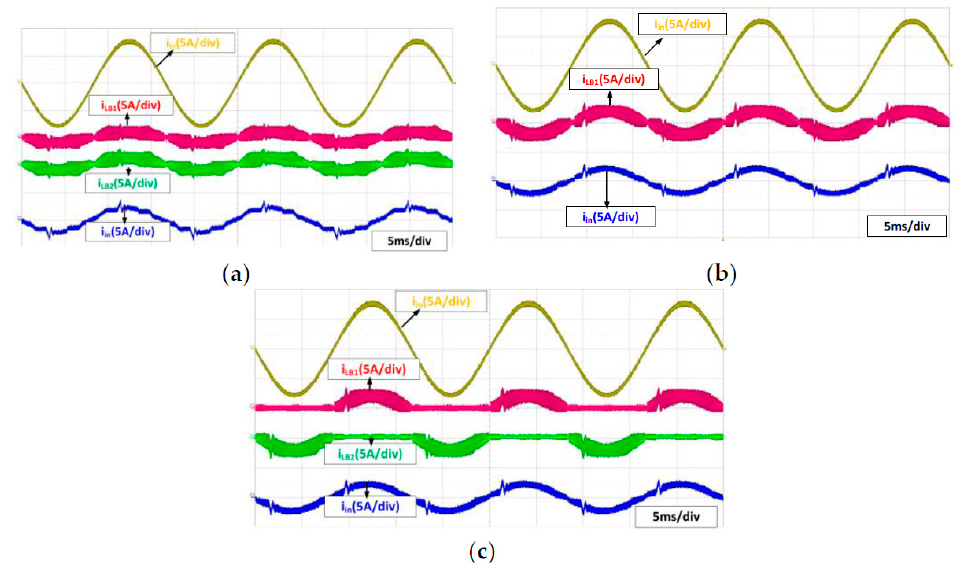
Figure 13. Captured waveforms of the PFC stage at 10% load condition. ( a ) Conventional inter- leaving control. ( b ) Single phase control. ( c ) Modified PFC ON/OFF control. control. ( b ) Single phase control. ( c ) Modified PFC ON/OFF control.